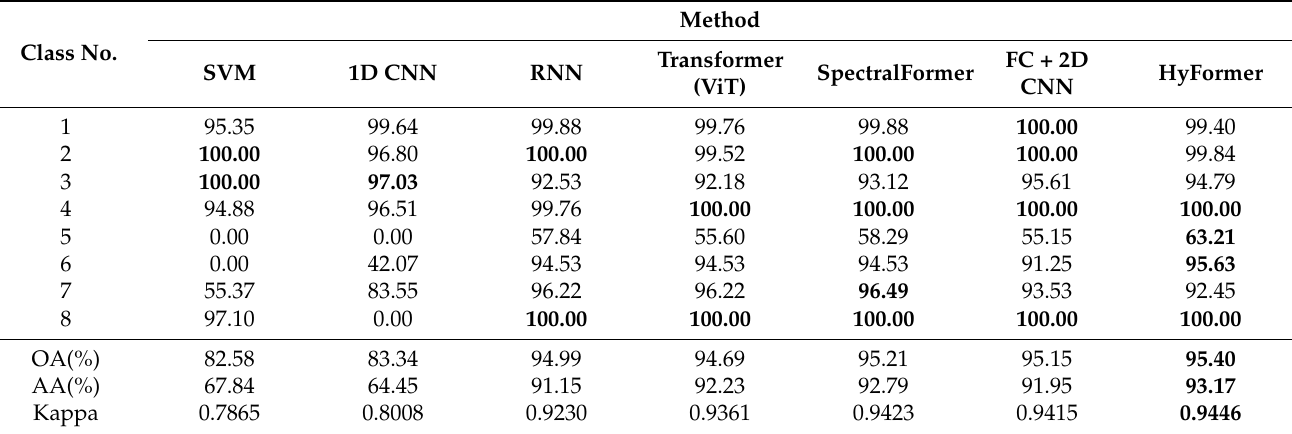
Table 7. Comparison of classification results of different classification methods applied on the testing set of Nanxun District,